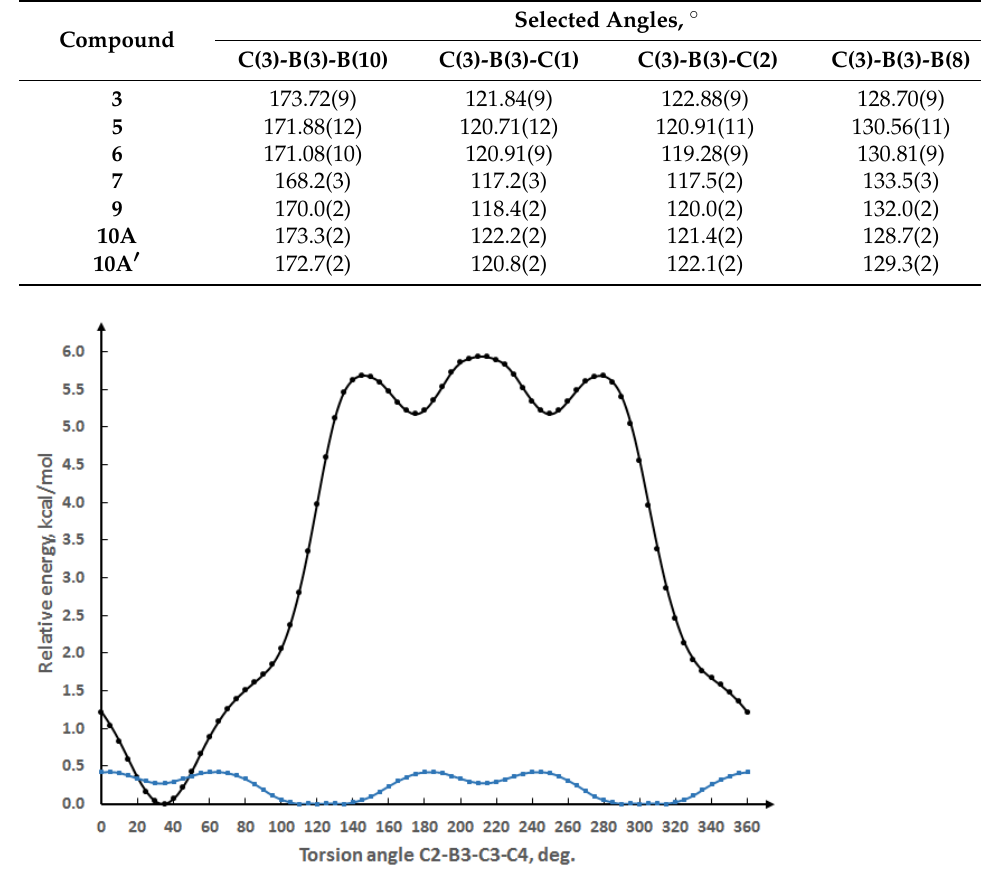
Table 1. Some selected angles in 3-aryl- ortho -carboranes 3 , 5 – 7 , 9 and 10 .